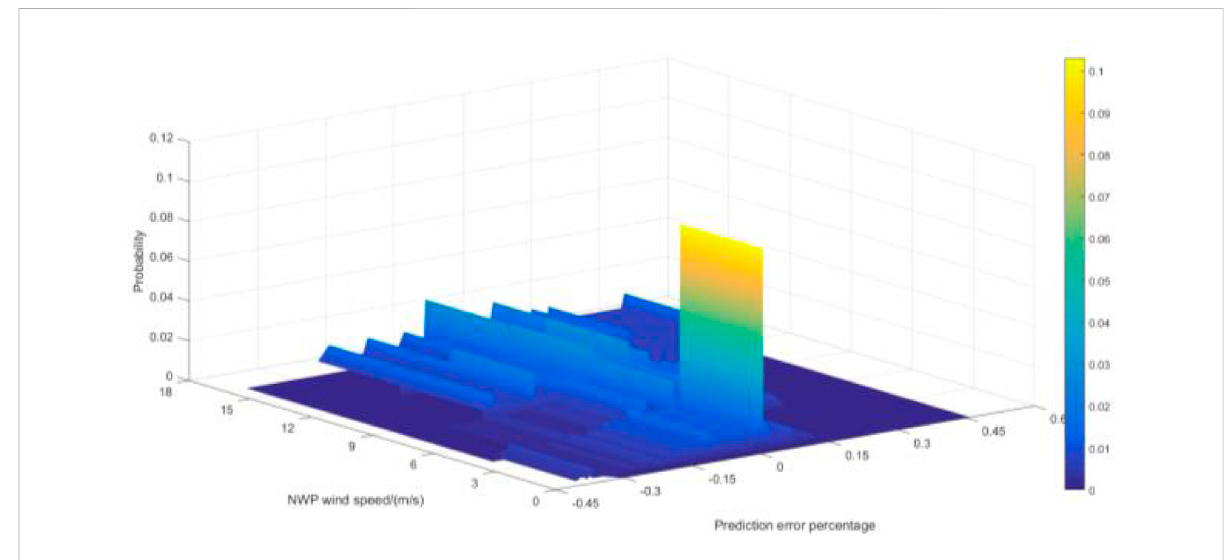
FIGURE 1 Joint probability distribution of prediction